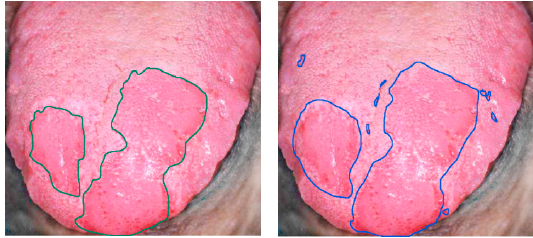
Figure 10. Delineation of the tongue tumor region in [146]. Expert labeling (left) and classifier prediction of tumor regions (right). Reproduced from [146]; Creative Commons BY 4.0; published by MDPI (2012).